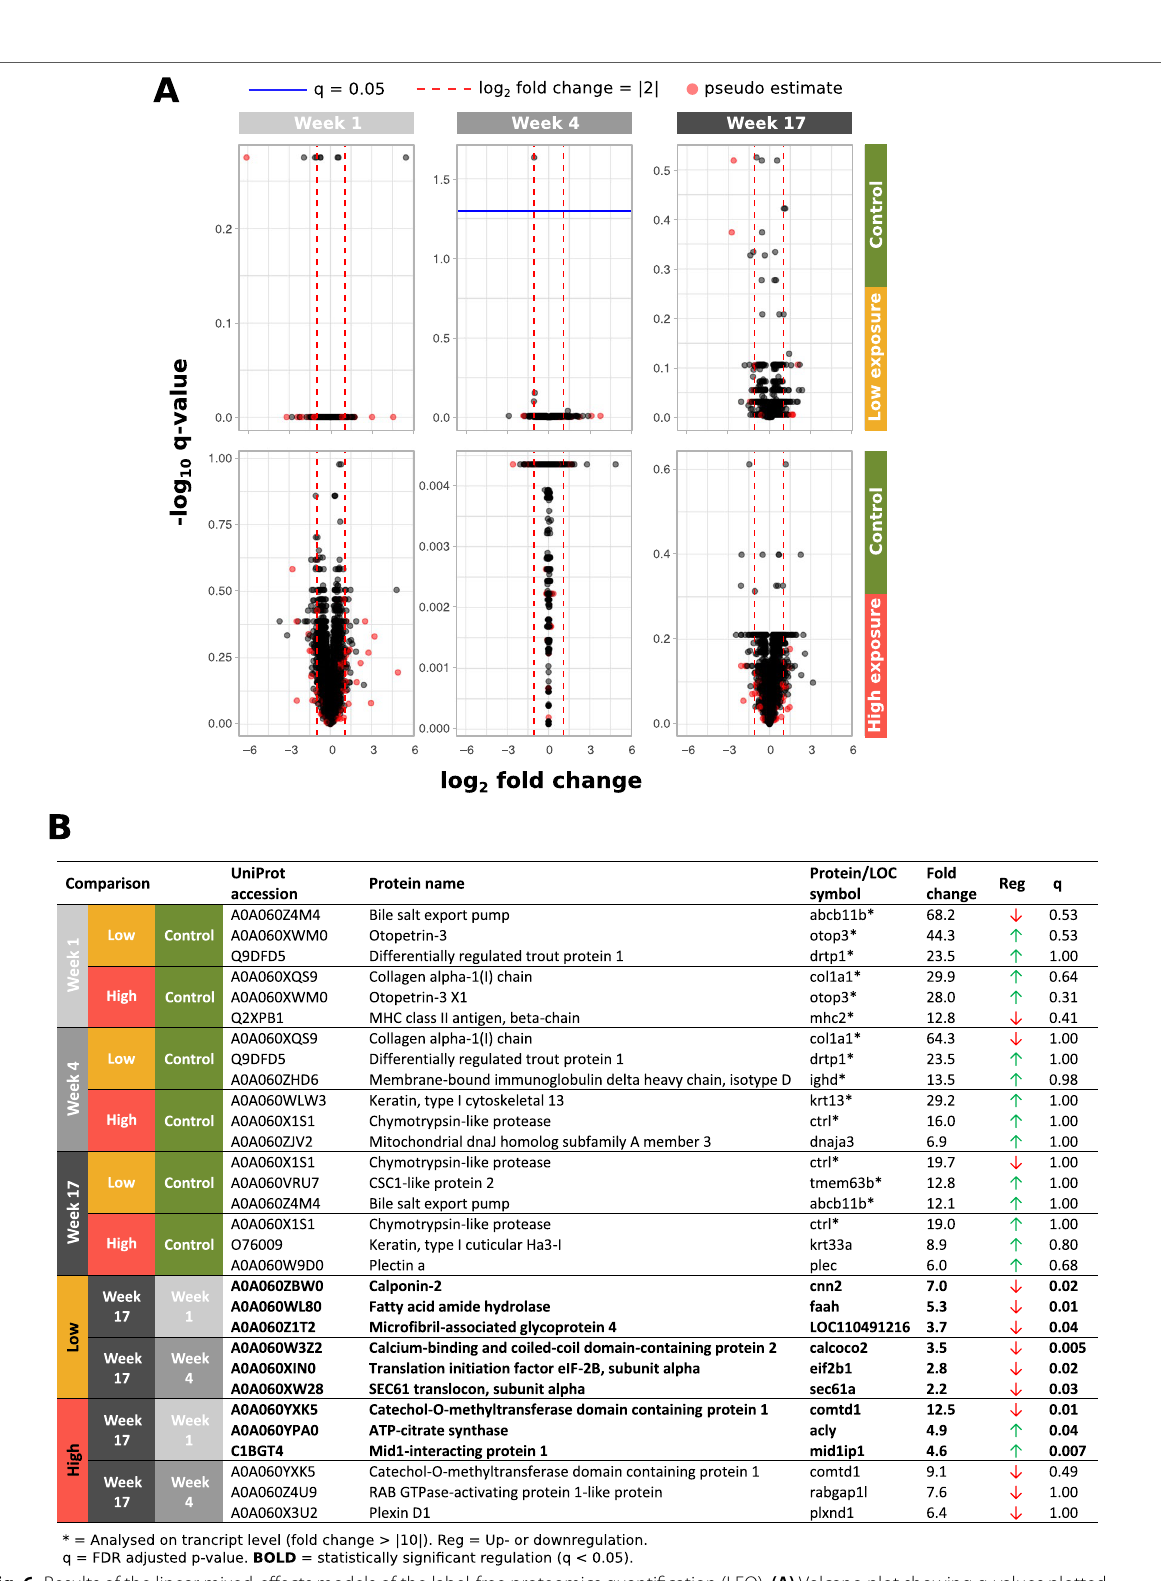
Fig. 6 Results of the linear mixed-effects models of the label-free proteomics quantification (LFQ). (A) Volcano plot showing q-values plotted against log 2 fold changes. (B) Table of the top three regulated proteins identified by contrast analysis for each contrast. Information about the general function of the listed proteins can be found in Table